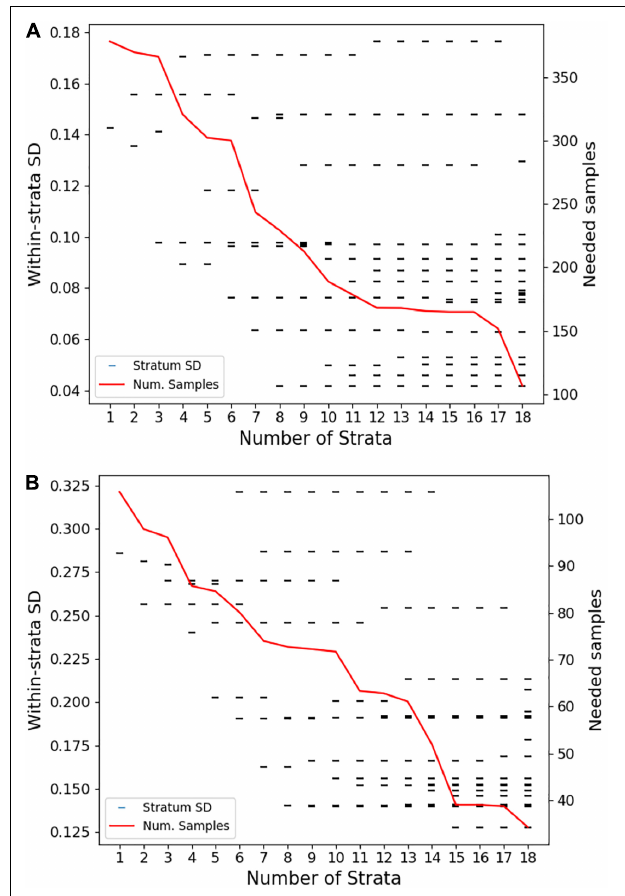
FIGURE 5 | Sensitivity of the number of field-based transects (samples) needed to meet regional uncertainty criteria as the number of strata are increased from 1 to 18 based on regional variation in (A) live coral cover and (B) fine-scale reef rugosity. Tick marks indicate the within-stratum standard deviation or sampling error predicted when treating South Kona as one stratum ( k = 1) to the 18 final strata based on the entire analysis. The red line indicates the total number of field-based transects (samples) required regionally at different levels of stratification (1–18), resulting in (A) 117 transects based on live coral and (B) 35 transects based on fine-scale reef